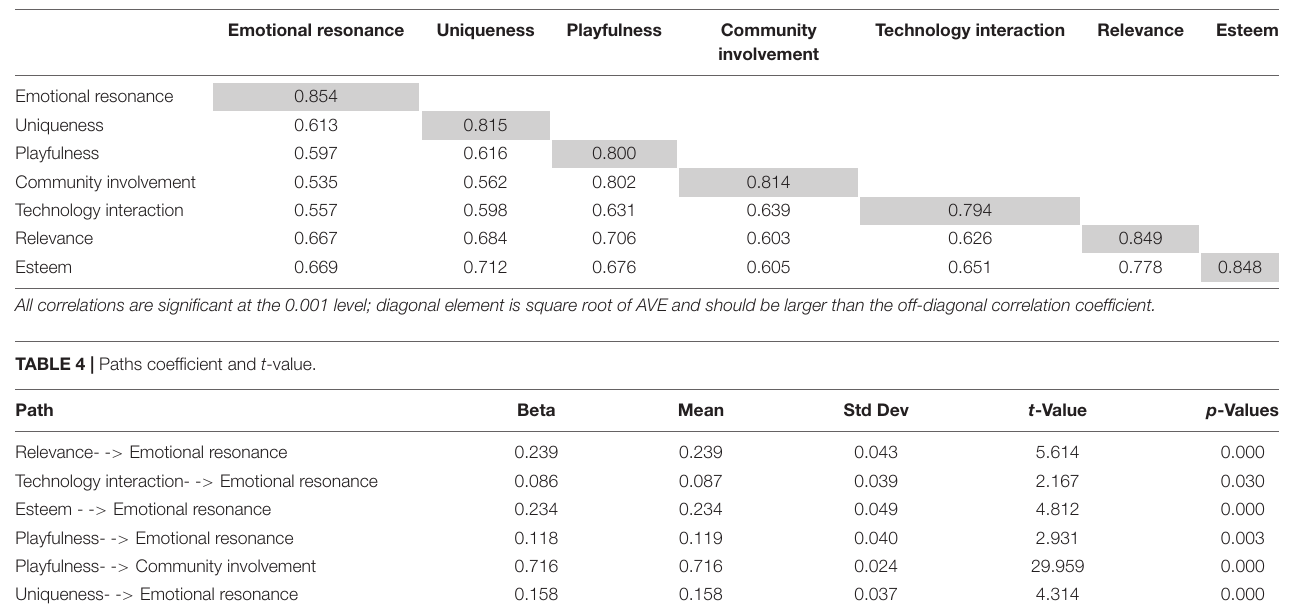
TABLE 3 | The discriminant validity of research model.